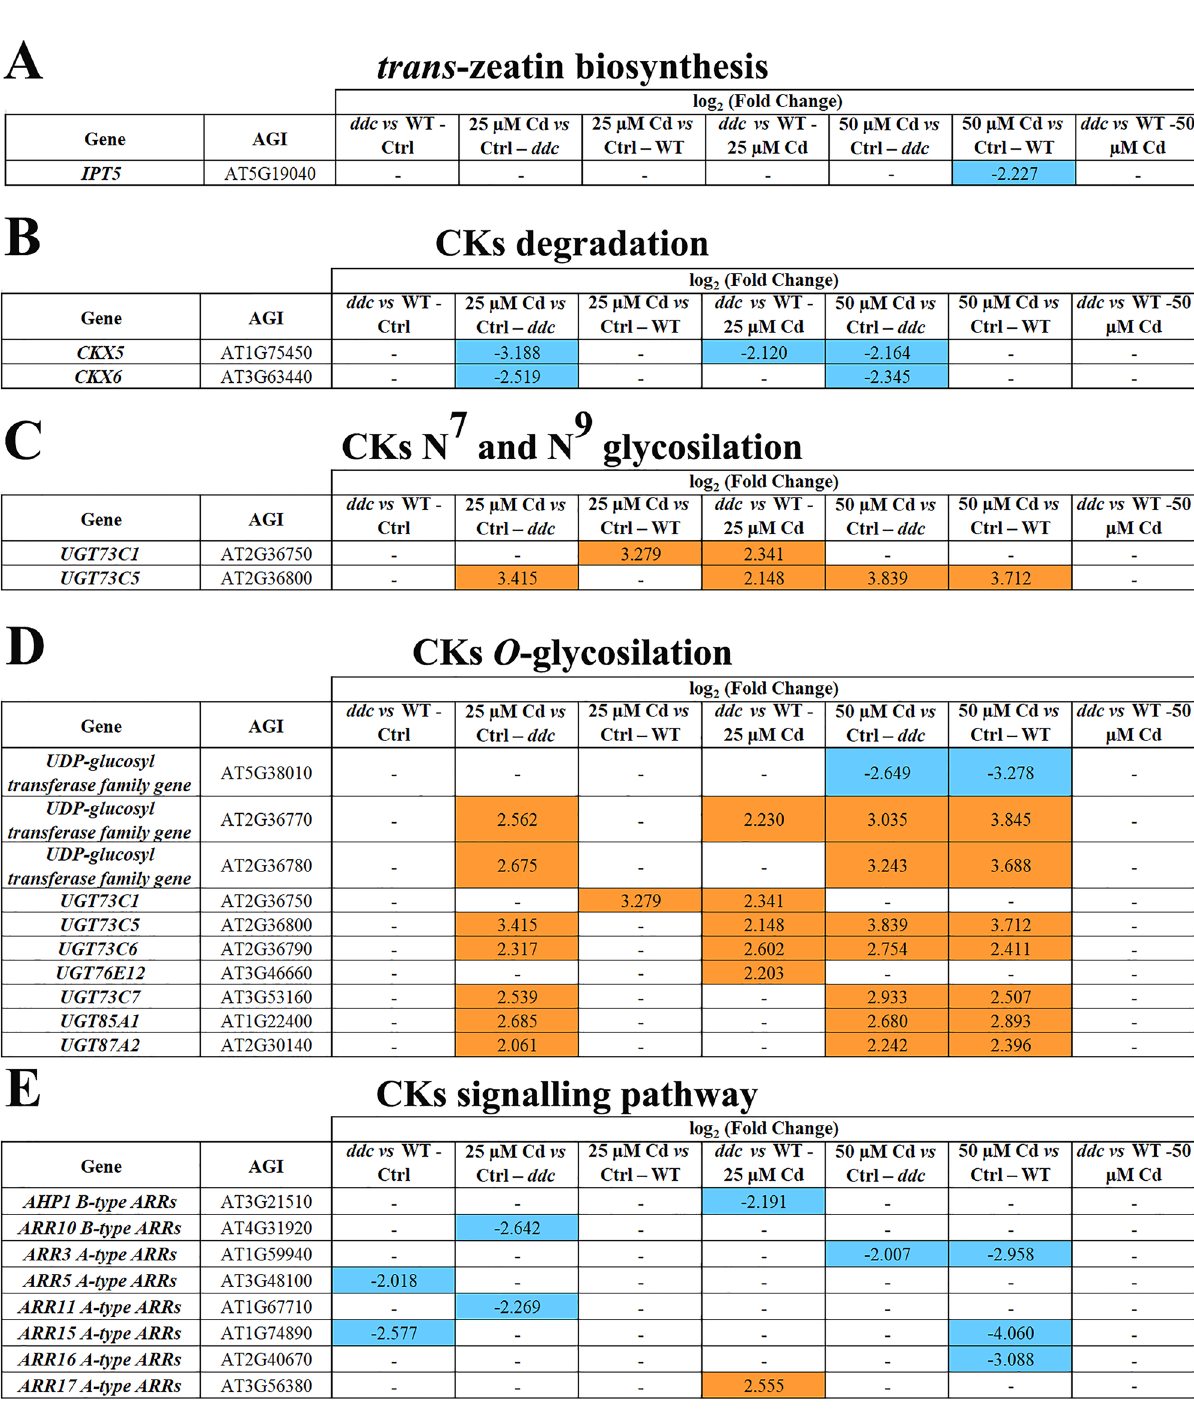
downregulated, respectively. (Fig. 5B). At 50 µM Cd, JAZ s were overexpressed in both ddc and WT (Fig. 5B). No differences were detected in ddc vs WT exposed to Cd (Fig. 5B). Globally, Cd negatively impacted on the GP related to JA biosynthesis especially in WT. Under Cd treatment hormone signalling was downregulated more in ddc than in WT, whatever concentration was applied.